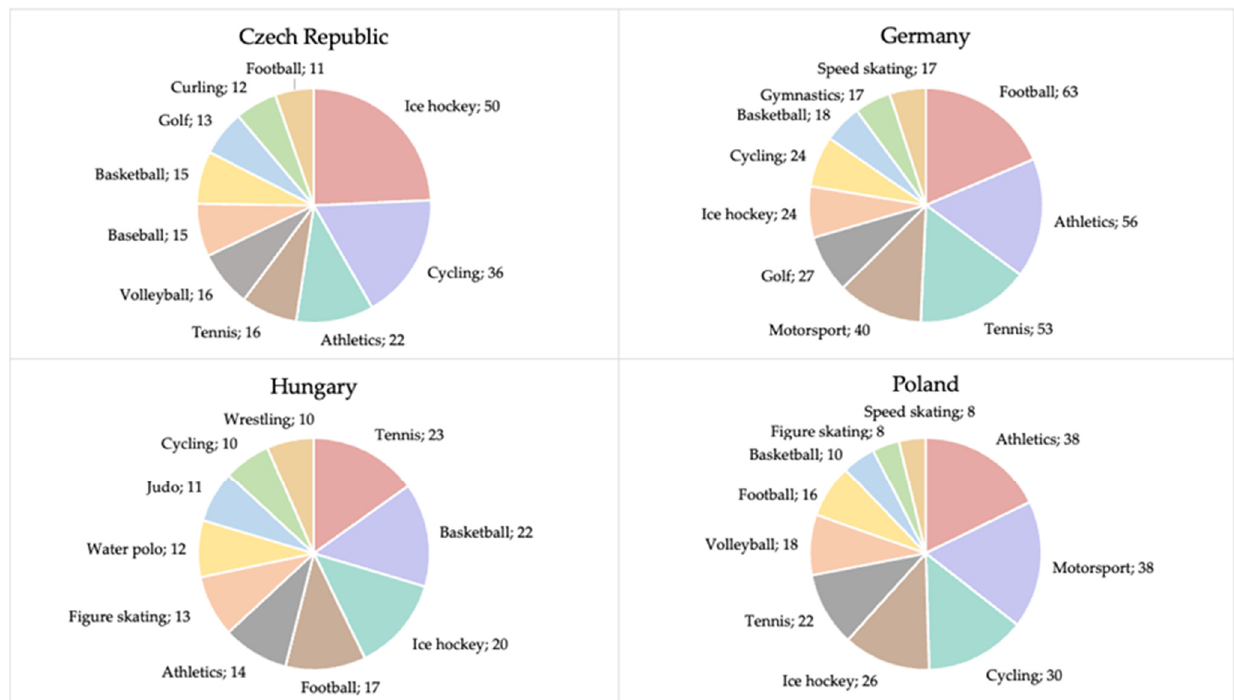
Figure 1. Comparison of sports competitions and tournaments organized in the selected countries; Source: Own elaboration based on the data collected (details are described in Section 3).